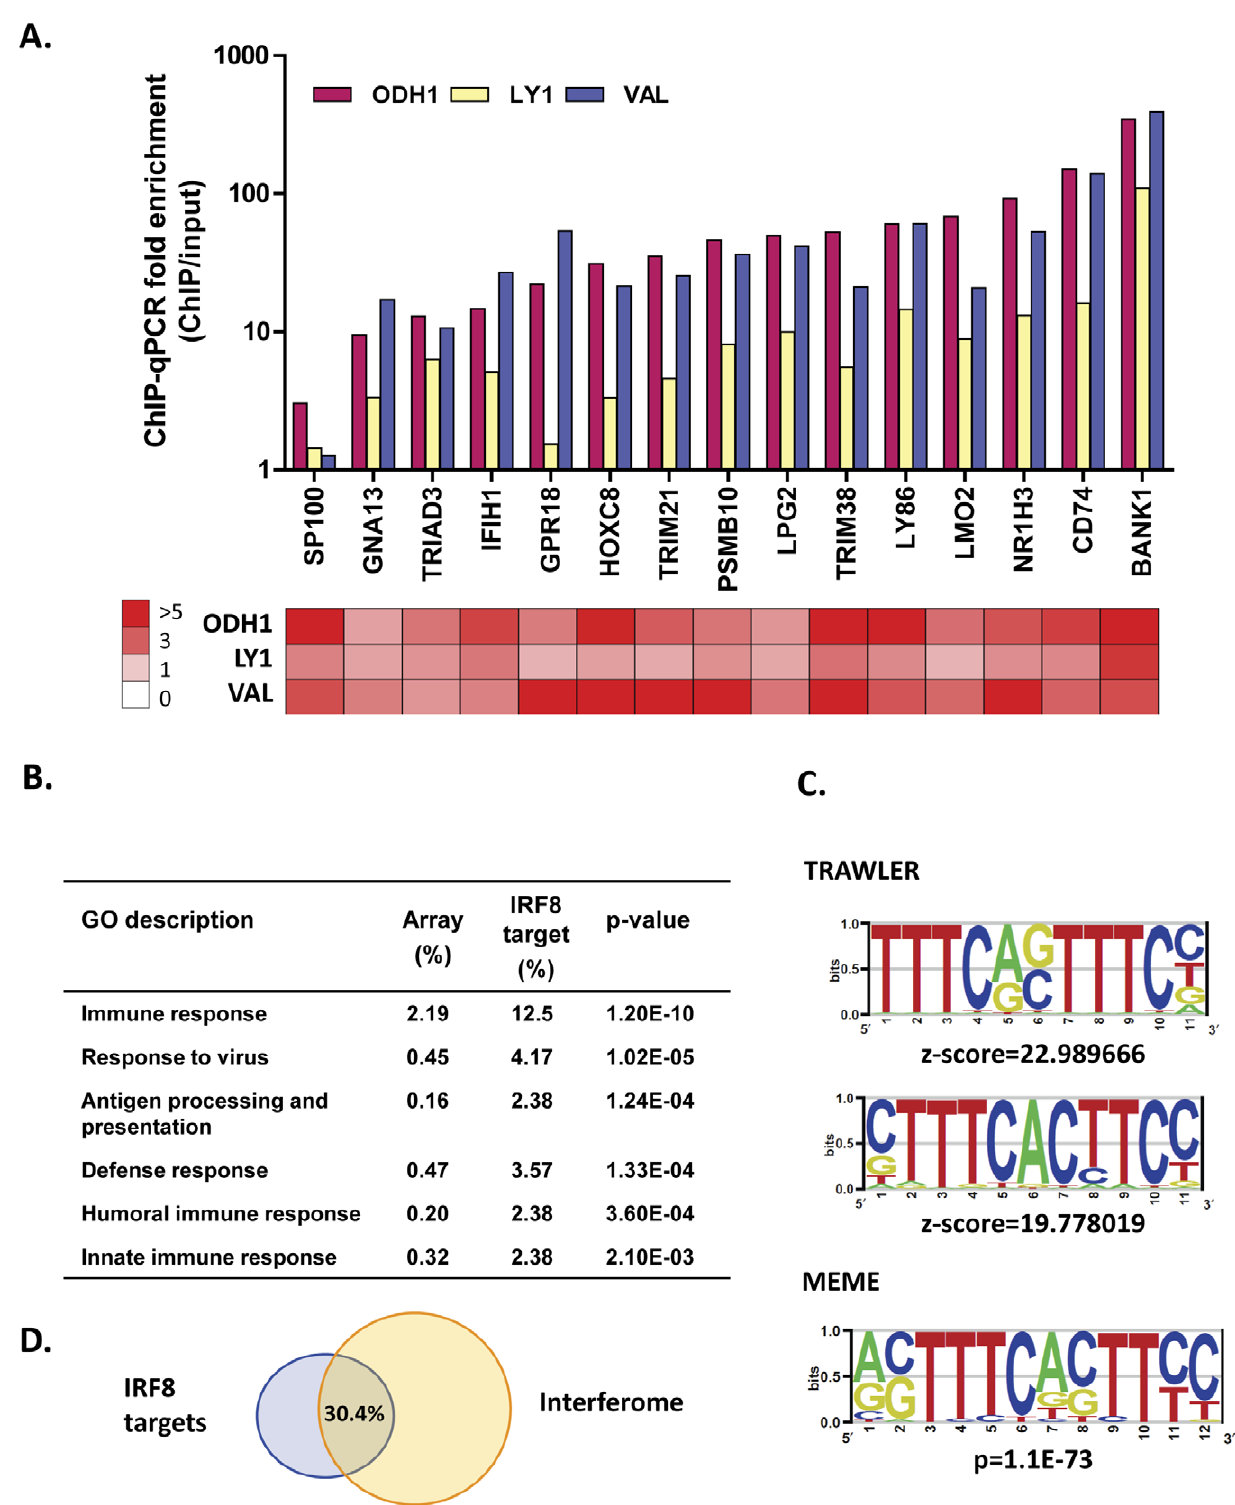
Figure 2. Validation of IRF8 ChIP-chip and functional classification of IRF8 targets (A) ChIP-qPCR validation using primer pairs surrounding the putative binding sites identified by ChIP-chip. For each locus, the fold enrichment comparing IRF8 ChIP DNA to input DNA is represented in the bar graph. The heatmap (lower panel) shows fold enrichment obtained from ChIP-chip. (B) Categorization of IRF8 targets by Gene Ontology (GO). Percents of genes in each category in the whole array or in the set of IRF8 targets are shown. p-values indicate significance of the enrichment for IRF8 targets in each GO category. (C) Motif analysis for IRF8 ChIP hits. Over-represented motifs were identified by TRAWLER and MEME. (D) A Venn diagram of IRF8 targets and interferon-responsive genes. The Interferome DB was used for identifying interferon-responsive genes.